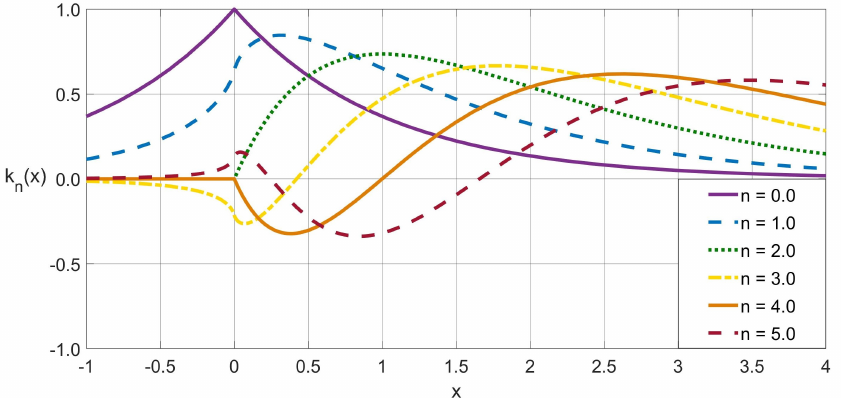
Figure 1. Bateman functions with positive integer orders as a function of argument x .